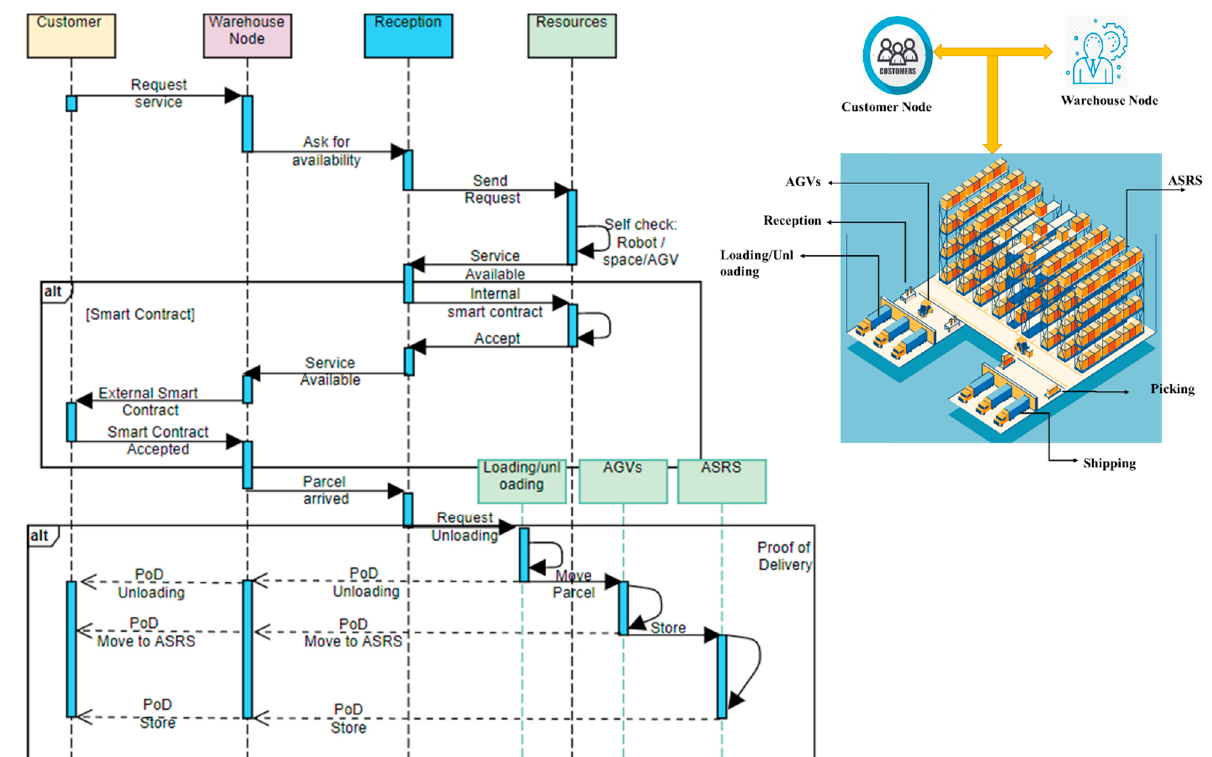
Figure 4. Process of requesting service from the distribution center .